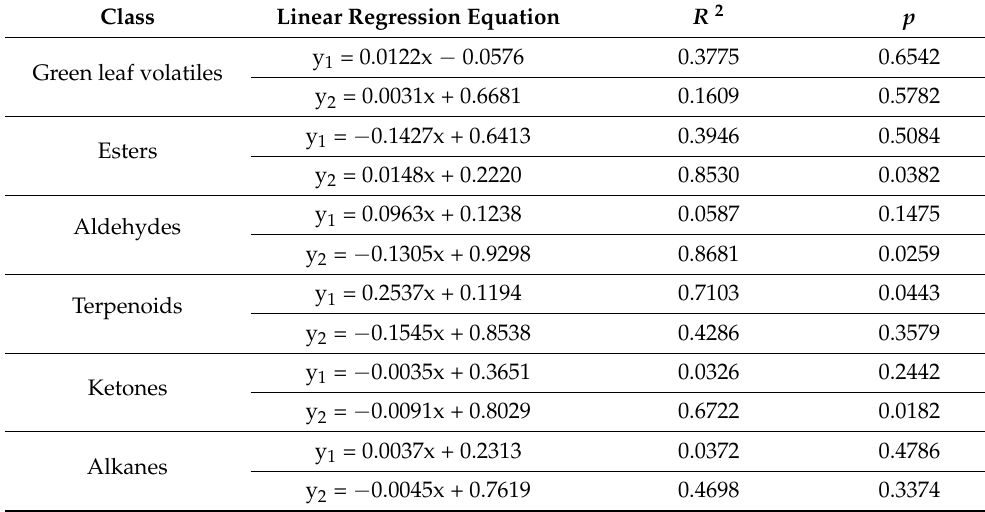
Figure 4. Quantities of specific volatiles released by Chinese cabbage plants in response to six treat- ments. HP: healthy plants; MDP: mechanically damaged plants; RTP: regurgitate-treated plants; SIP: plants infested with S. litura for 12, 24, or 48 h. Values are means + SE. Bars labeled with different Table 1. Linear relationships between quantities of classes of volatiles emitted by Chinese cabbage plants under different treatments and the selection rates of M. similis and S. litura . Class Linear Regression